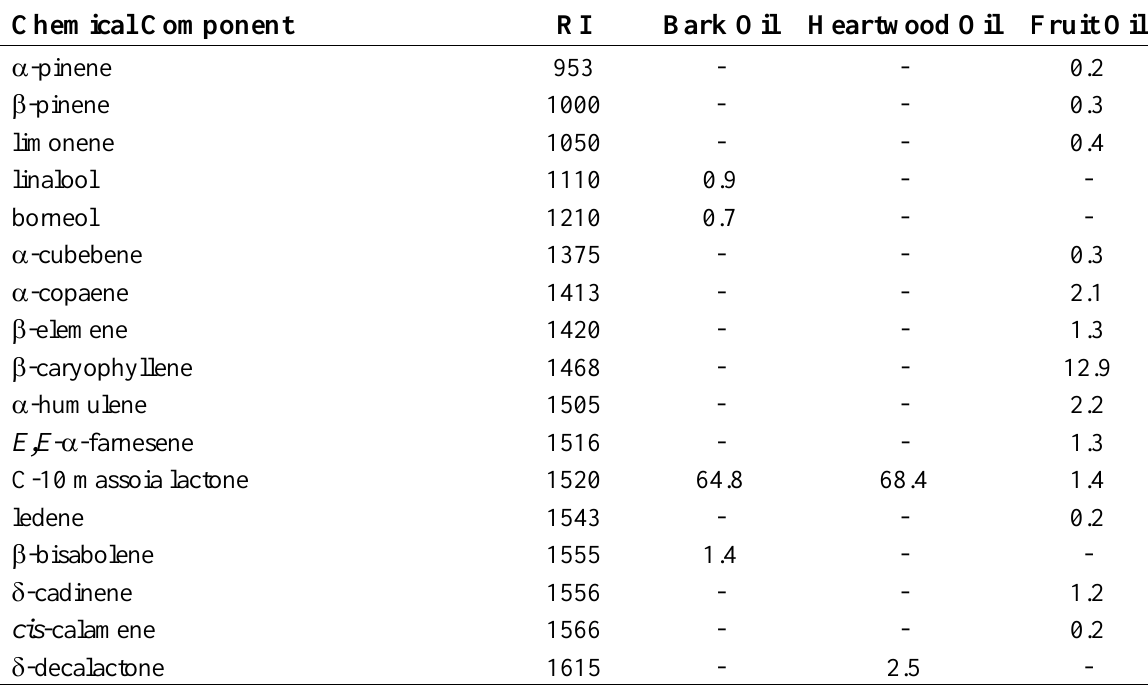
Table 1. A comparative analysis of the composition of the chemical constituents (area %) in the bark, heartwood and fruit oils of C. massoia